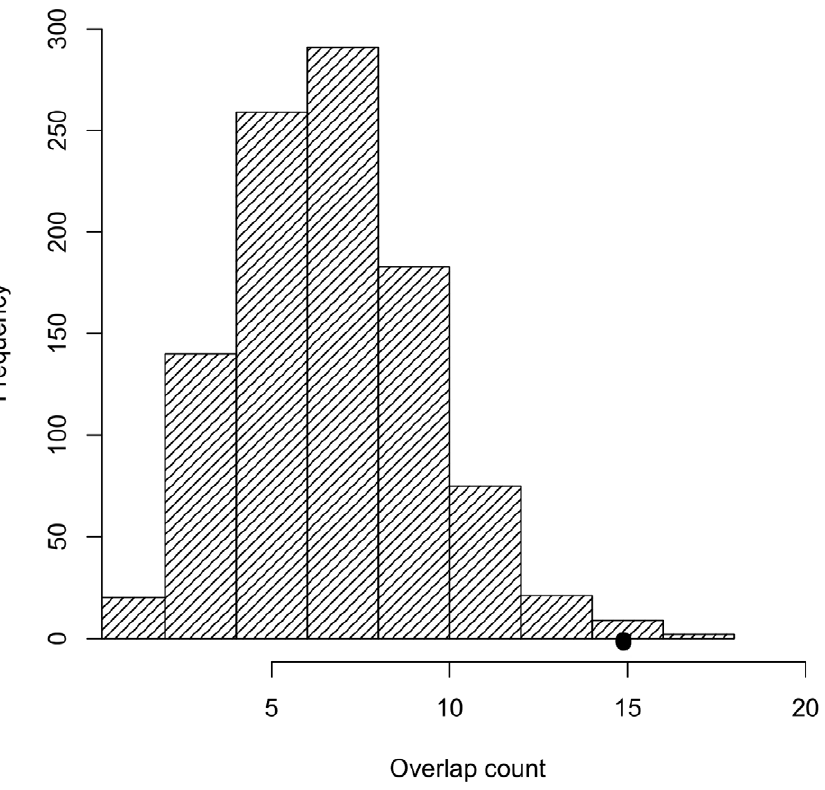
Figure 2. Trait-associated SNPs are significantly enriched for SNPs tagging tCNVs. The distribution of the number of SNPs tagging tCNVs in 1,000 draws of SNPs from bins matched for minor allele frequency to the trait-associated SNPs is shown in the bar graphs.